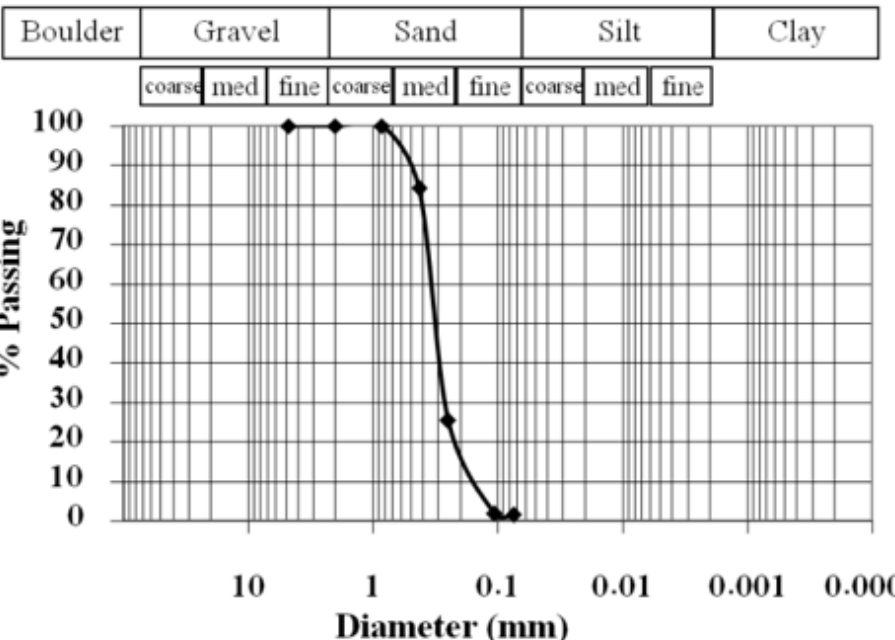
Figure 7. The sieve analysis of specimen 1 at 65.7E km at El-ferdan